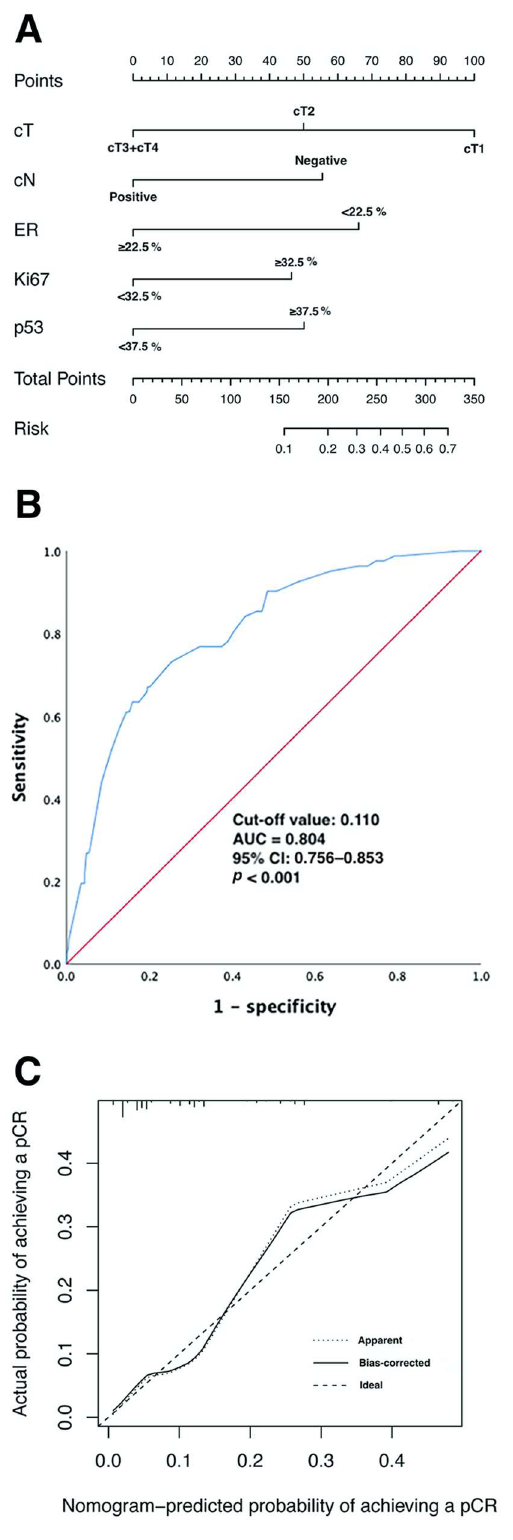
Figure 3. ( A ) Predicting the probability of pCR in the nomogram. ( B ) ROC curves for the nomogram model to predict the probability of achieving pCR in the primary cohort. ( C ) Calibration curves for the nomogram model predicting the probability of achieving pCR in the primary cohort. Abbreviations: pCR, pathological complete response; cT, clinical T staging; cN, clinical nodal status; ER, estrogen receptor; ROC, receiver operating characteristic; AUC, area under the curve; CI, confidence intervals.